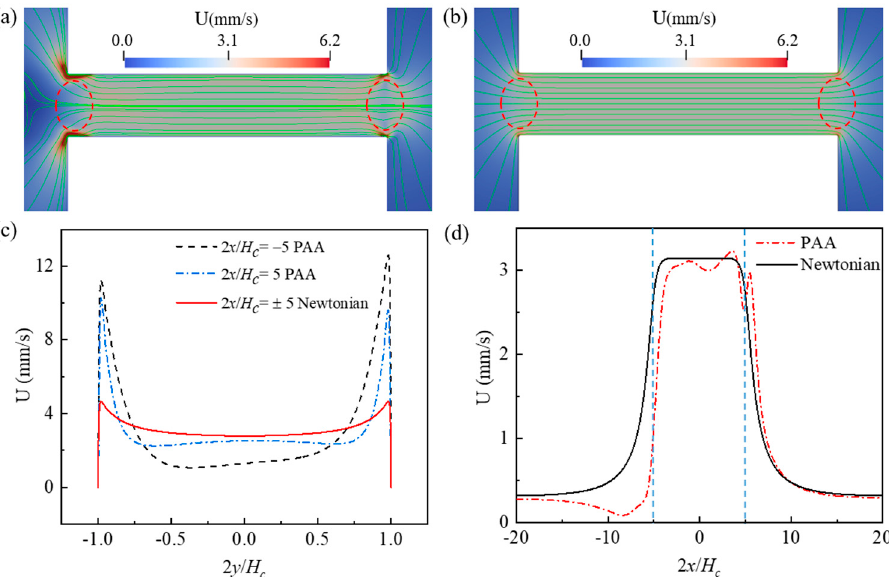
Figure 10. Streamlines and velocity magnitude for c p = 150 ppm and E app = 600 V/cm and Newtonian fluid at t = 1.78 s: ( a ) 150 ppm PAA solution, ( b ) Newtonian fluid with same total viscosity as 150 ppm PAA solution, ( c ) velocity magnitude profiles at 2 x / H c = ± 5, ( d ) velocity magnitudes profiles at y = 0 (The blue dash lines show the position of the contraction microchannel). The color bar represents the velocity magnitude